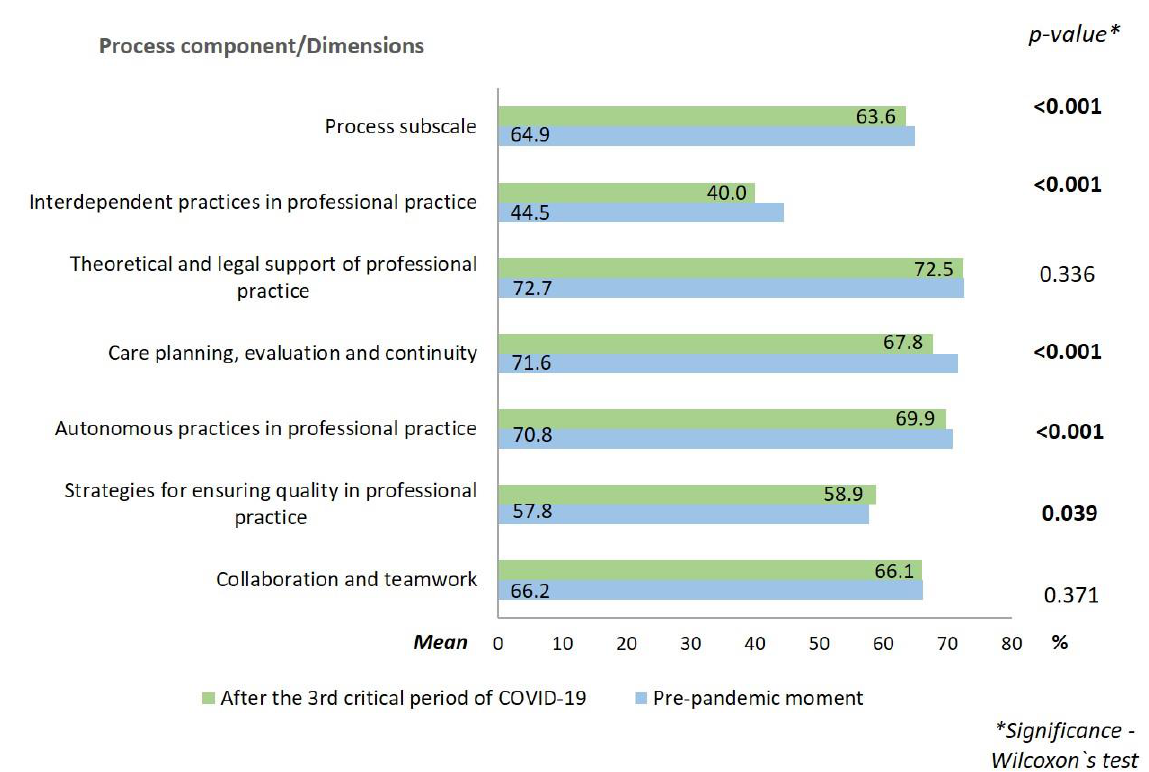
Figure 2. Mean scores of the process component of nursing professional practice environments at the pre-pandemic moment and after the 3rd critical period of COVID-19.